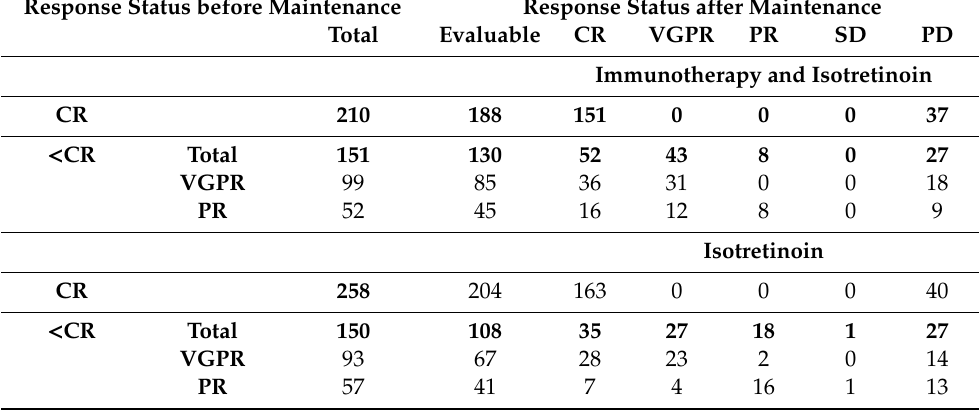
Response for immunotherapy and control populations. Legend: CR